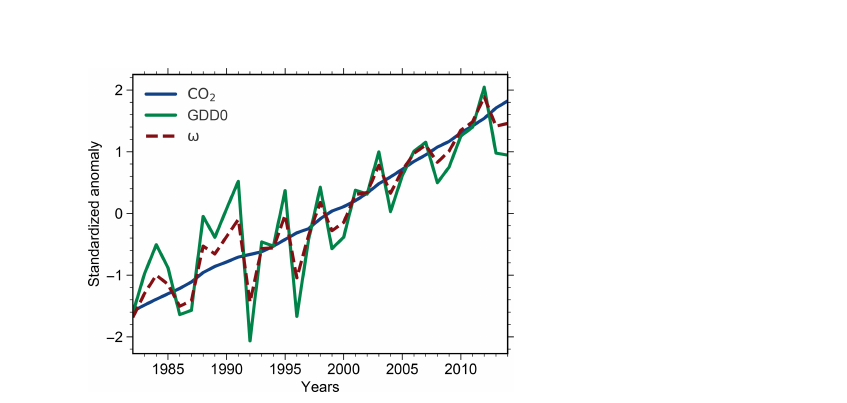
Figure A1. Standardized temporal anomalies of annual averaged atmospheric CO 2 concentration (blue solid line), area-weighted averaged GDD0 for NHLs (green solid line), and their leading principal component ω (red dashed line) in observations.